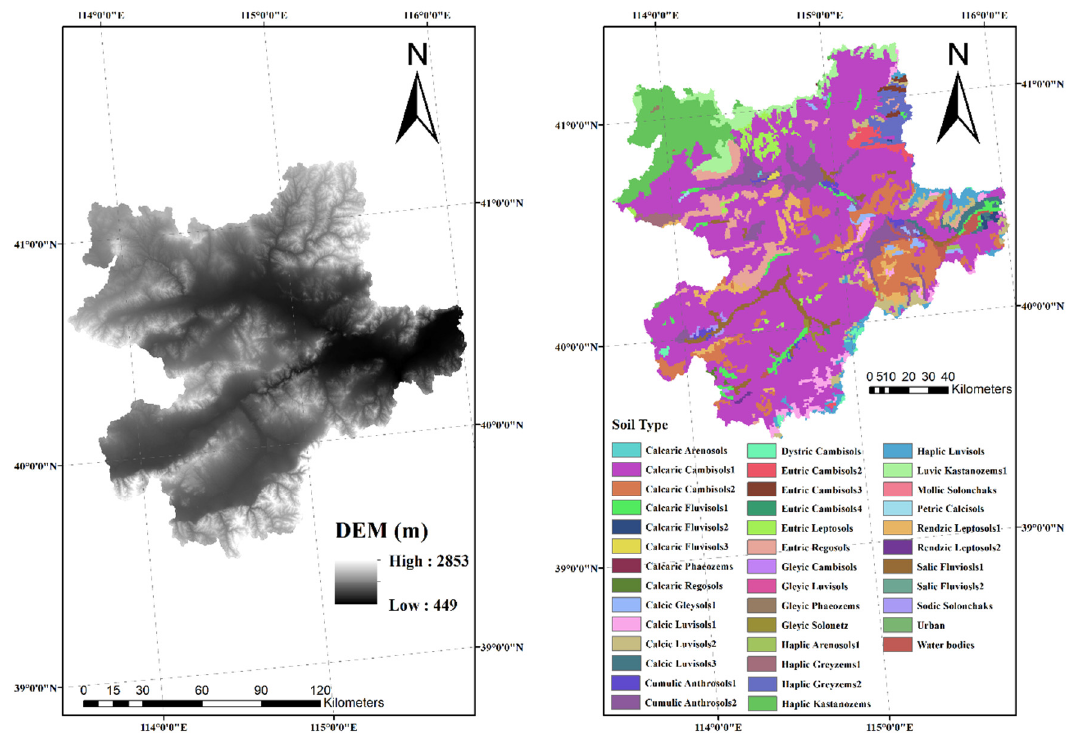
Figure 2. DEM and distribution of soil types in the study area in 2016.